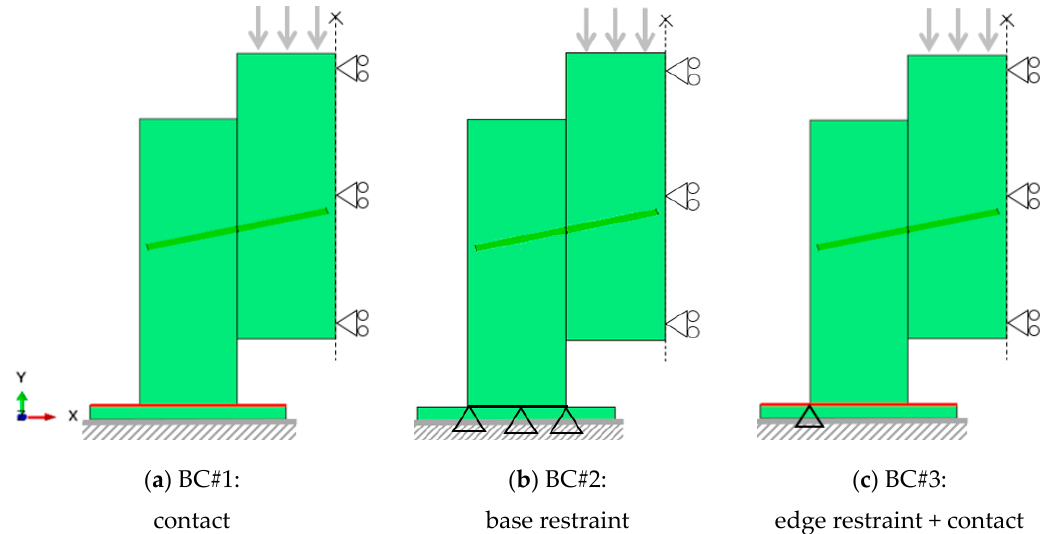
Figure 17. Analysis of boundary condition effects on the PO performance of TTC joints.